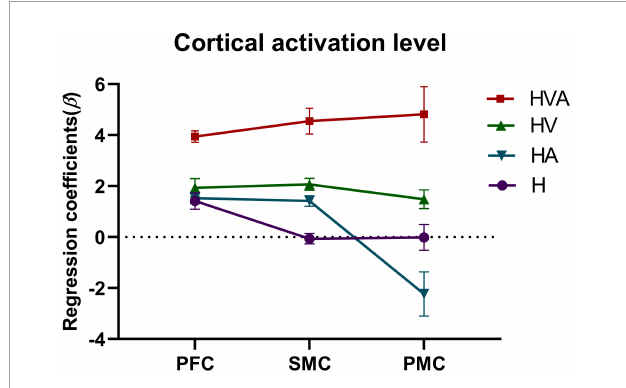
FIGURE7 Statistical analysis of the regression coefficients ( β ) under four experimental conditions of three regions of interest (ROIs). SMC, sensorimotor cortex; PFC, prefrontal cortex; PMC, premotor cortex. The abbreviations in the figure represent haptic (H), haptic + auditory (HA), haptic + visual (HV), and haptic + visual + auditory (HVA).